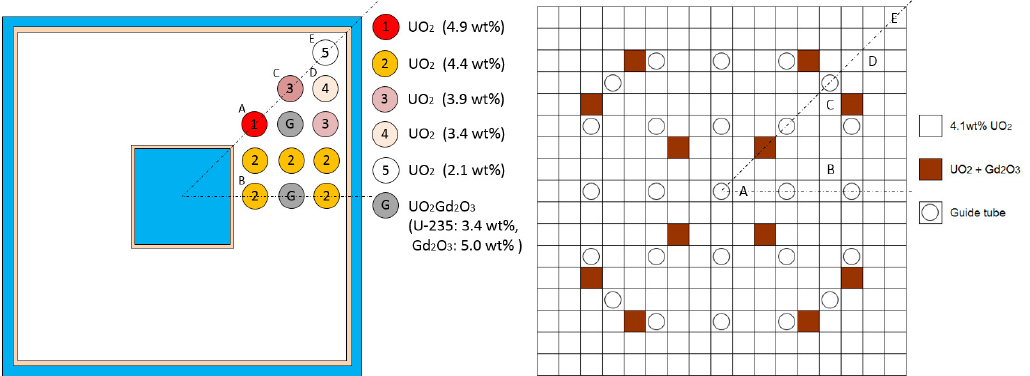
Figure 1: Geometric configurations of BWR and PWR fuel assemblies (left: BWR, right: